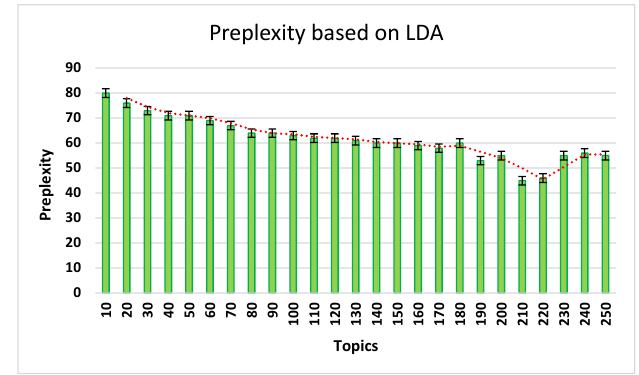
Figure 5. LDA-based preplexity records.